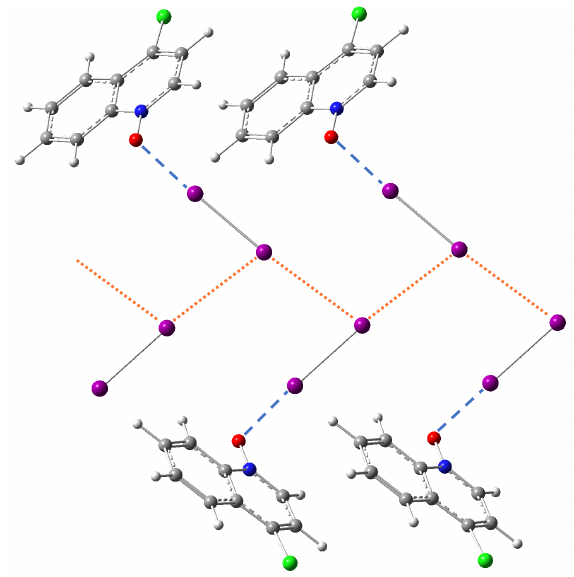
Figure 8. Optimized crystal model structure showing the I · · · O halogen bonding Q (blue dashed lines) between diiodine and acceptor molecule Q . The orange dotted lines show the I 2 · · · I 2 interaction